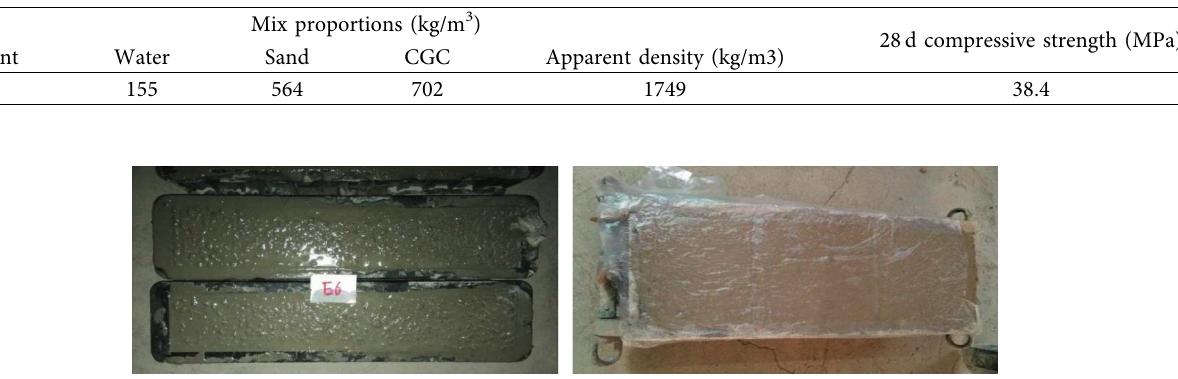
Table 5: Mixing proportions for LWAC with CGC.